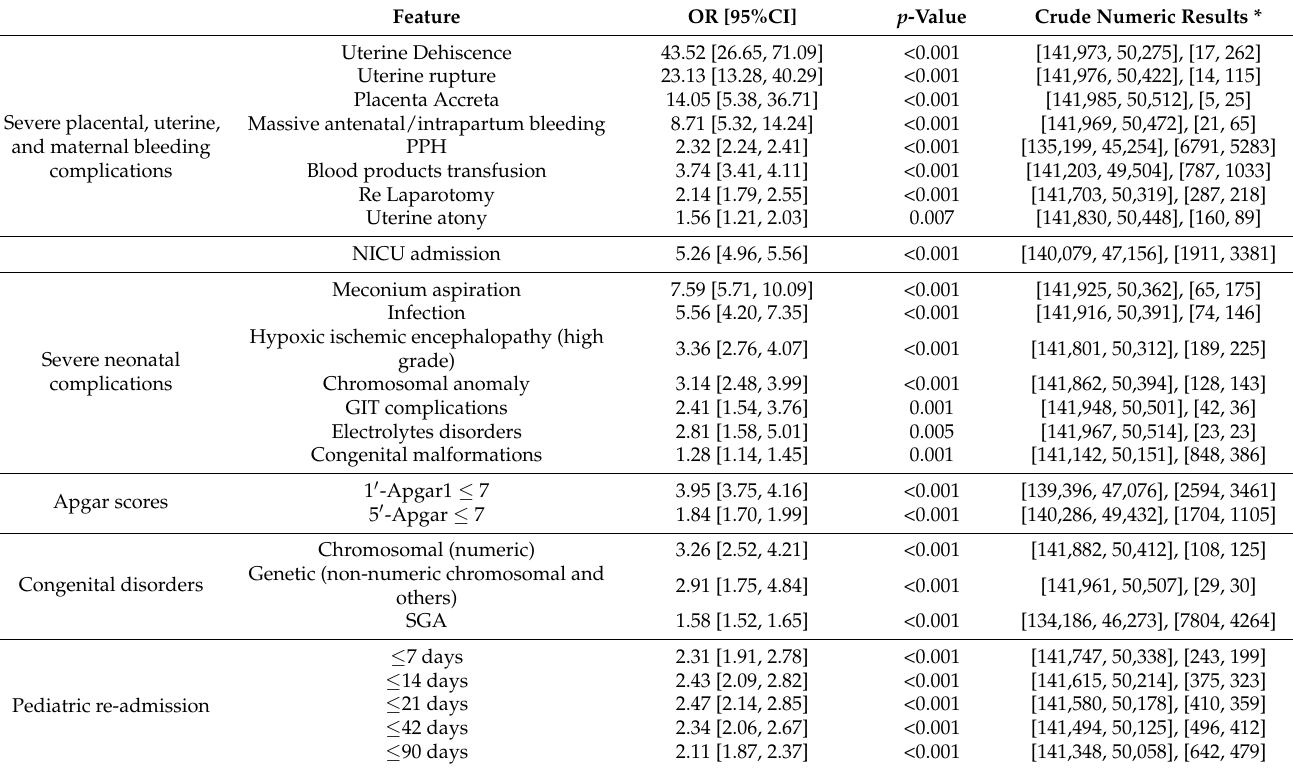
Table 3. Maternal and neonatal adverse outcomes: high- and low-risk groups for NICU admission. Feature OR [95%CI] p -Value Crude Numeric Results